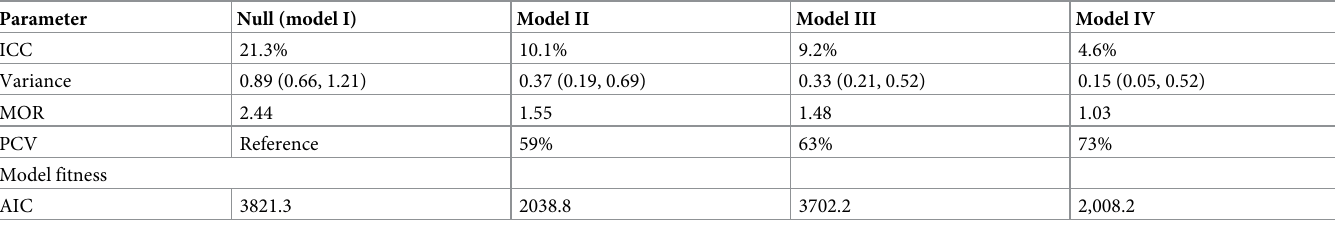
Table 4. Random effect and model comparison for predictors of early initiation of antenatal care among reproductive-age women in Ethiopia,